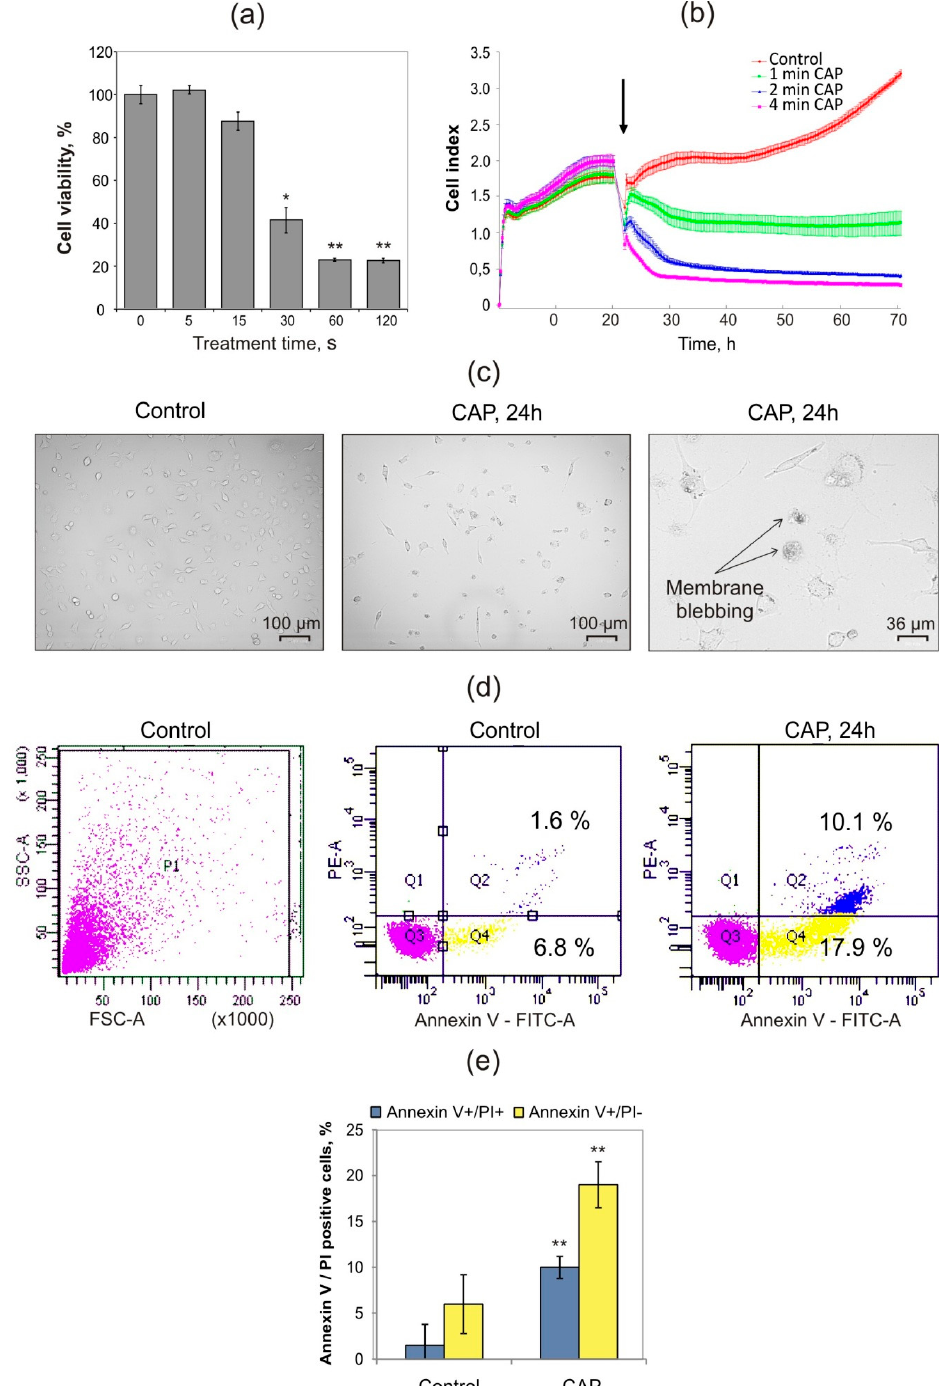
Figure 2. Plasma induces the death of MX − 7 cells. ( a ) Cell viability (MTT) assay was performed 24 h after the CAP treatment. The data are presented as a percent of the non-treated cells (100%). ( b ) Real-time iCELLigence curves for the MX − 7 cells exposed to CAP. The black arrow indicates the moment of irradiation; ( c ) Bright-field microscopy of the CAP-treated MX − 7 cells. Representative photos of three independent repeats. ( d ) Flow cytometry analysis of apoptosis in the CAP-treated MX − 7 cells. Cells were stained with Annexin-V / propidium iodide (PI). Ten thousand cells were recorded in the P1 population where Annexin-V + / PI- cells then were defined as apoptotic cells, Annexin-V + / PI + were defined as late apoptotic / secondary necrotic cells. Representative histograms of three independent repeats. ( e ) Quantification data for Annnexin V / PI positive cells. Student’s t -test was applied to compare the control and experimental groups. Data are represented as the mean ± SEM, * p ≤ 0.05 and ** p ≤